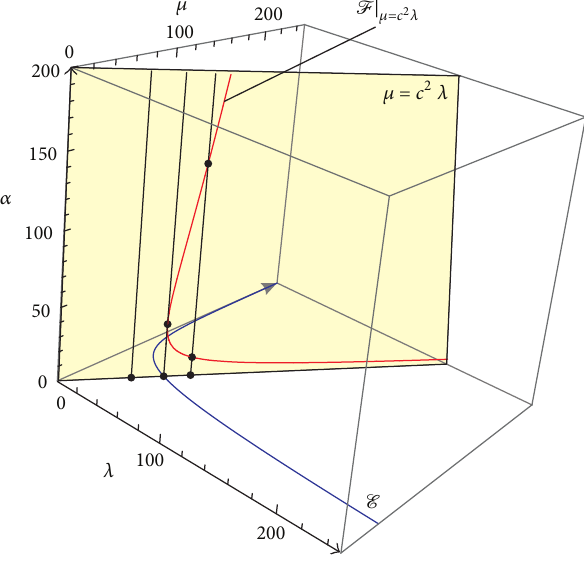
Figure 3: The case 𝑝 = 3 , 𝑞 = 1/2 , 𝑘 = 2 , 𝑚 = 1 and 𝑐 = 1.2